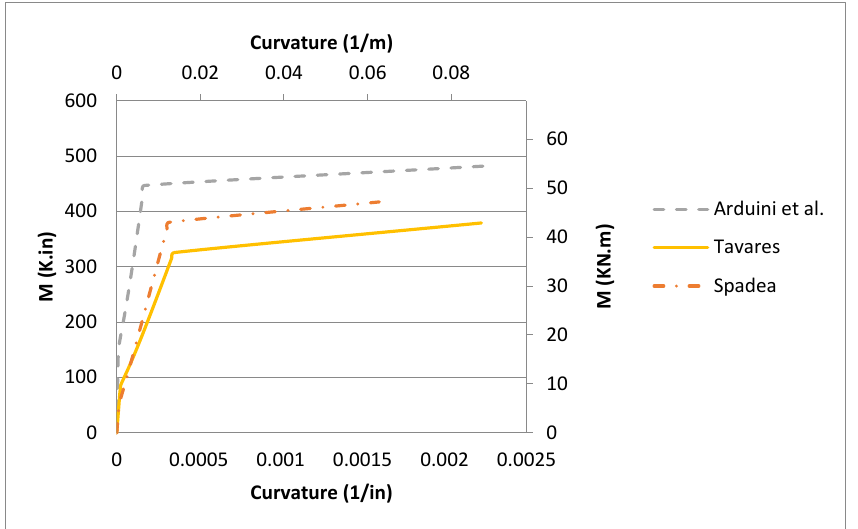
Figure 9. Arduini et al. (1997) [14], Tavares et al. (2008) [13] and Spadea et al. (1998) [15] moment vs. curvature analytical graphs.